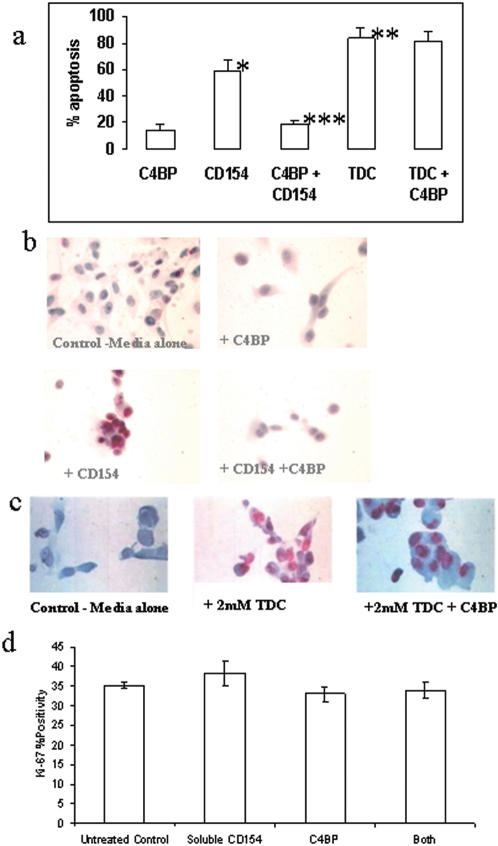
Panel a) This histogram shows inhibition of sCD154 mediated apoptosis by C4BP but not apoptosis induced by 0.2 mM TDC. * sCD154 or **TDC induced similar levels of cholangiocyte apoptosis when experimental error was taken into account (59.7%+/−7.5 and 83.4%+/−7.7 and respectively) relative to control (p<.005)***. C4BP + sCD154 reduced apoptosis to control levels (p<0.005) whereas C4BP had no effect on TDC induced apoptosis (81.5%+/−6.7). C4BP/sCD154 also had no effect on TDC mediated apoptosis (data not shown) Panel b and c show representative cytospins stained for fragmented DNA using ISEL. Panel d) Histogram summary of the effects of sCD154 and C4BP on Cholangiocyte proliferation. Primary human cholangiocytes were cultured in 24-well culture plates and simulated with either sCD154, C4BP or a mixture of both. Following incubation for 24 hours, the cells were fixed and proliferation assessed by immunohistochemical staining for Ki-67 antigen. No significant difference was seen between the un-stimulated controls and treated samples, implying that sCD154, C4BP or the mixture had any effect on cholangiocyte proliferation. These data represent the mean of three different counted areas per well repeated for three different liver preparations.